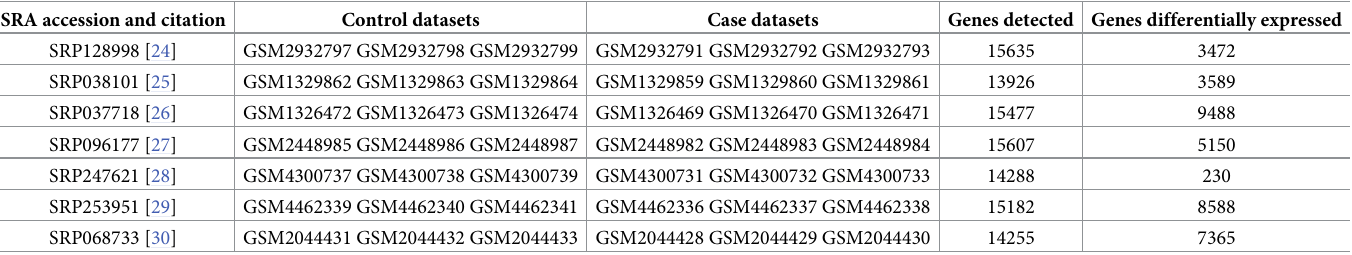
Table 1. Seven independent RNA-seq experiments used for functional enrichment analysis. Detection threshold is an average of 10 reads per sample. Differentially expressed genes are defined as FDR < 0.05 using DESeq2. SRA accession and